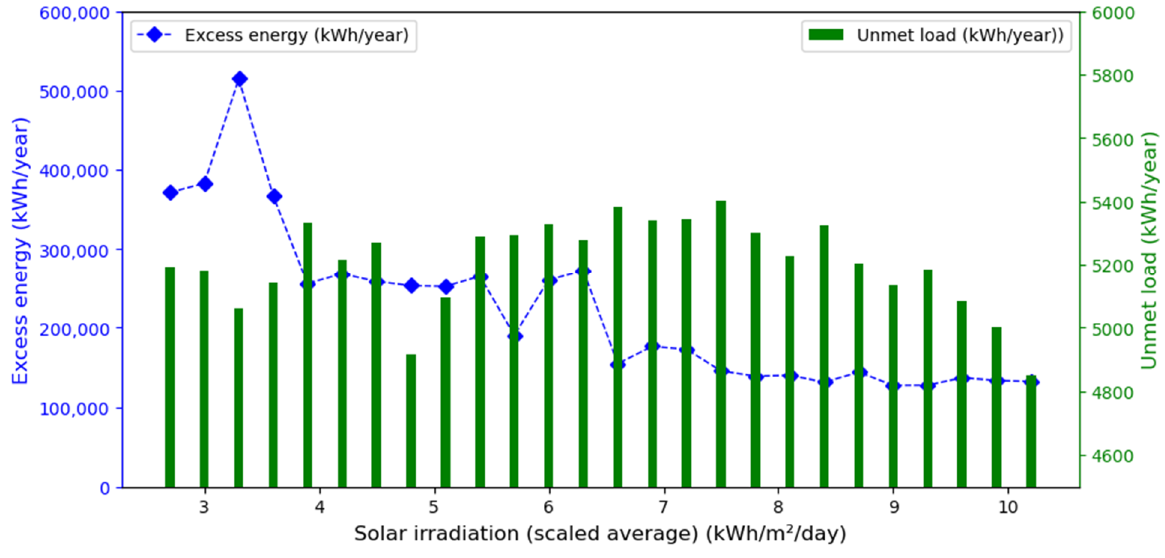
Figure 16. The impact of changing the solar radiation value on the excess energy and unfulfilled electric load of the optimal EV charging scheme.